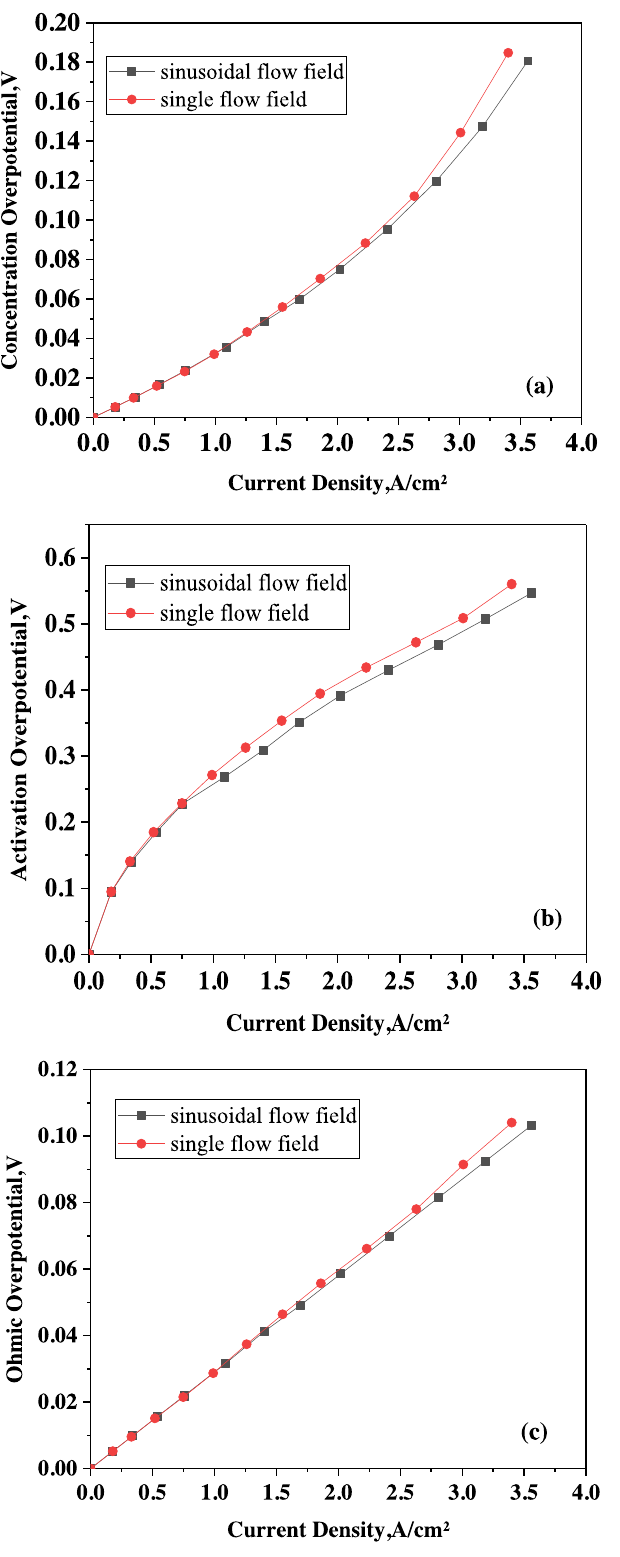
Fig. 7. (a) The concentration, (b) the activation, (c) the Ohmic overpotantials curves for two different fl ow fi eld